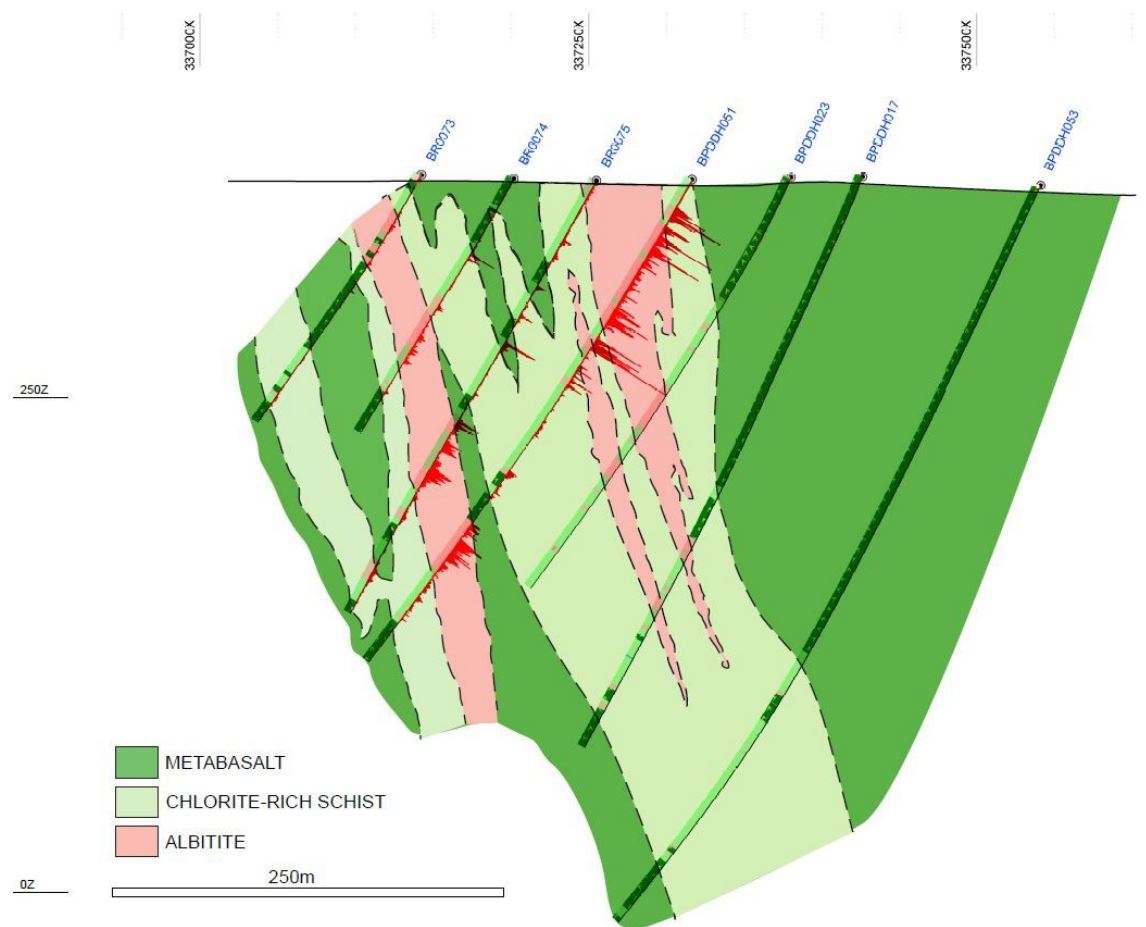
Figure 5. Representative NW-SE cross-section of the Bikini